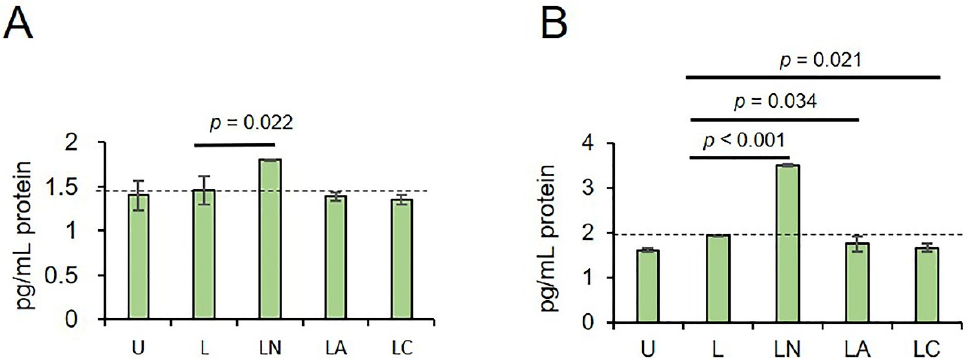
Figure 5. The effect of LPS-Az and LPS-Cf on IL-1 β secretion in A549 ( A ) and PC3 cells ( B ). U: Untreated, L: LPS, LN: LPS-ng, LA: LPS-Az, LC: LPS-Cf. p values were calculated using one-way ANOVA and Tukey’s post-hoc tests. Dotted line indicates the secreted IL-1 β in LPS primed cells. IL-1 β levels were analyzed using Interleukin-1 beta-EIA-BEST kit (VECTOR-BEST, Novosibirsk, Russia). Results were captured using a TECAN Infinite 200 Pro fluorimeter (Grödig, Austria) at a wavelength of 450 nm and quantified using a standard curve. Each ELISA was completed in technical duplicates.